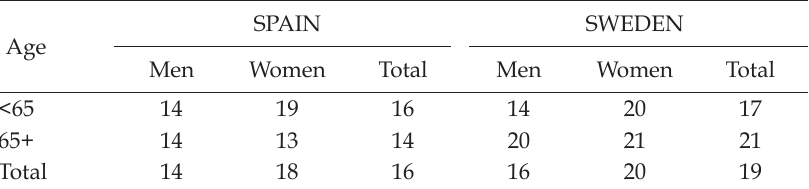
Chi-square test of independence, sample size: Spain ( p = 0.722), Sweden ( p = 0.342). Sources: Our own computations on the UDP and ESUC